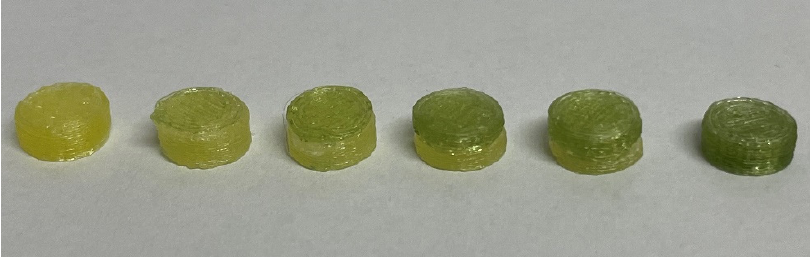
Figure 4. Image of tablets with increased diazepam (DZP) contents: 0, 1, 2, 5, 7.5, and 10 mg (from